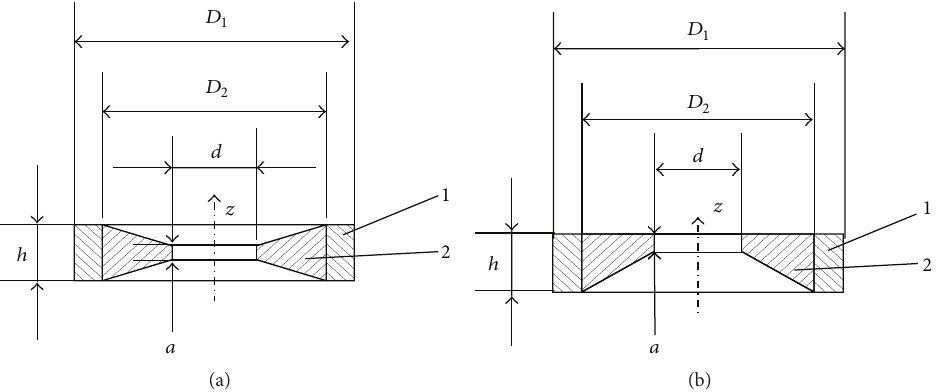
Figure 1: Principle design of the ring type actuators with symmetrical waveguide (a) and asymmetrical waveguide (b); 1, piezoceramic ring, 2,